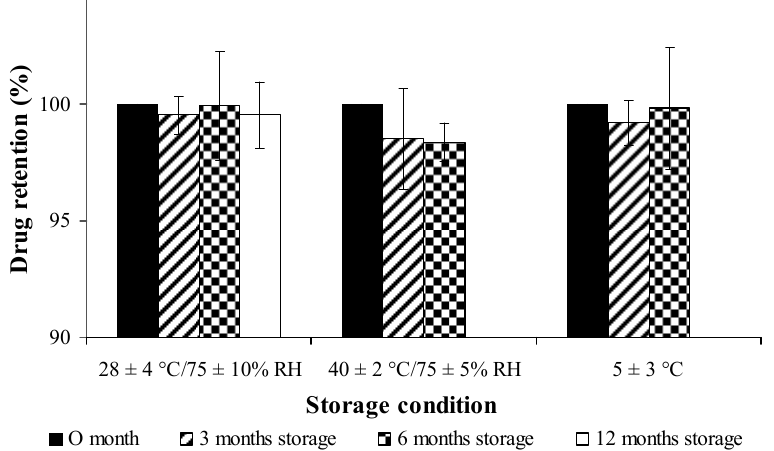
Figure 9. Stability study of free curcuminoids dried powder on percent drug retention at different conditions.